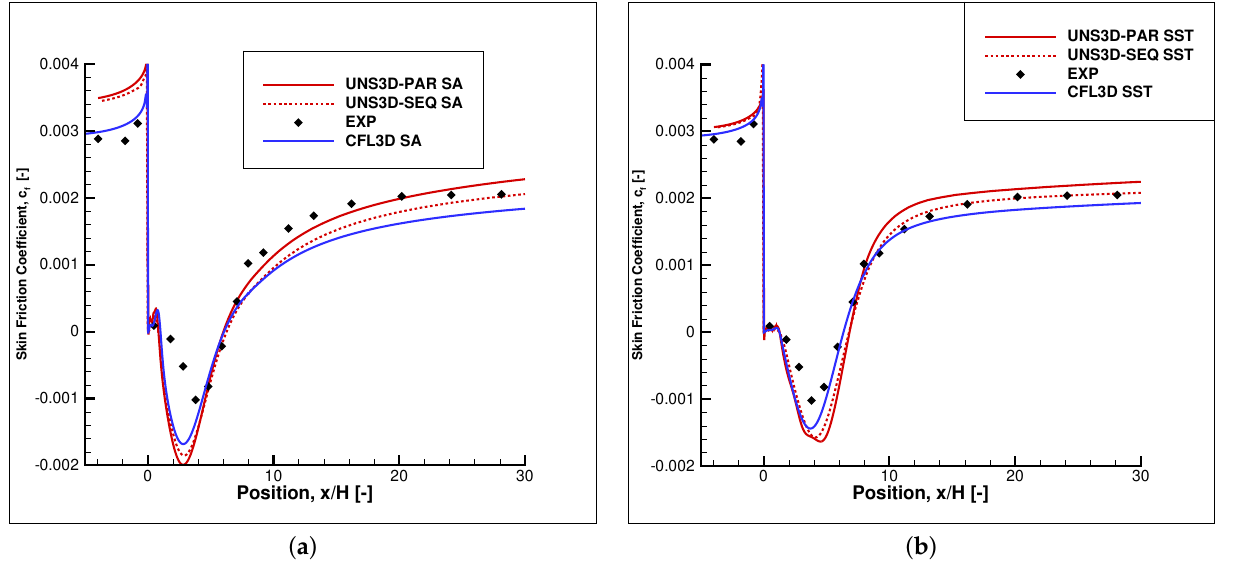
Figure 20. Coefficient of friction on backward-facing step: ( a ) Spalart–Allmaras, and ( b ) Shear Stress Transport. Figure 21 compares the measured and predicted turbulent shear stresses at four locations downstream from the step. The results predicted using the Shear Stress Transport model matched the turbulent shear stresses better than the Spalart–Allmaras